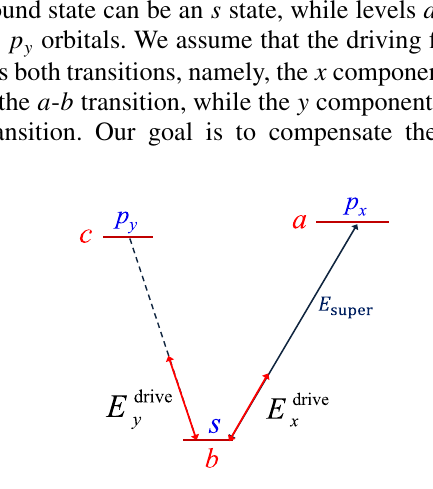
FIG. 14. Energy-level diagram of a He atom. FIG. 15. Three-level model of the